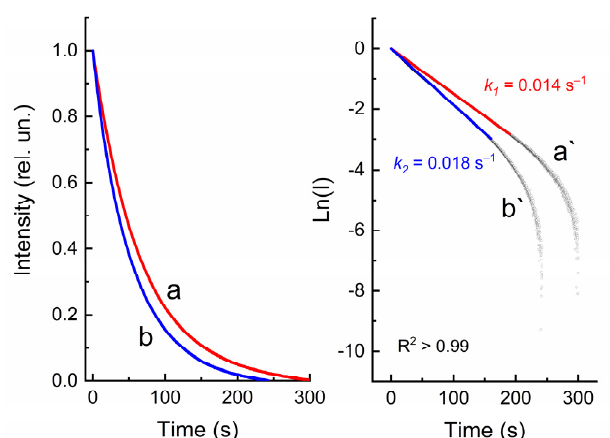
Figure 2. Normalized kinetic curves of the transition process 2 ′ → 2 , measured at 605 nm without ( a ) and upon irradiation ( b ) through a SZS–9 light filter (photobleaching). Linear anamorphoses ( a ′ ) and ( b ′ ) of kinetic curves ( a ) and ( b ) in the Ln (I)–time (s) coordinates.